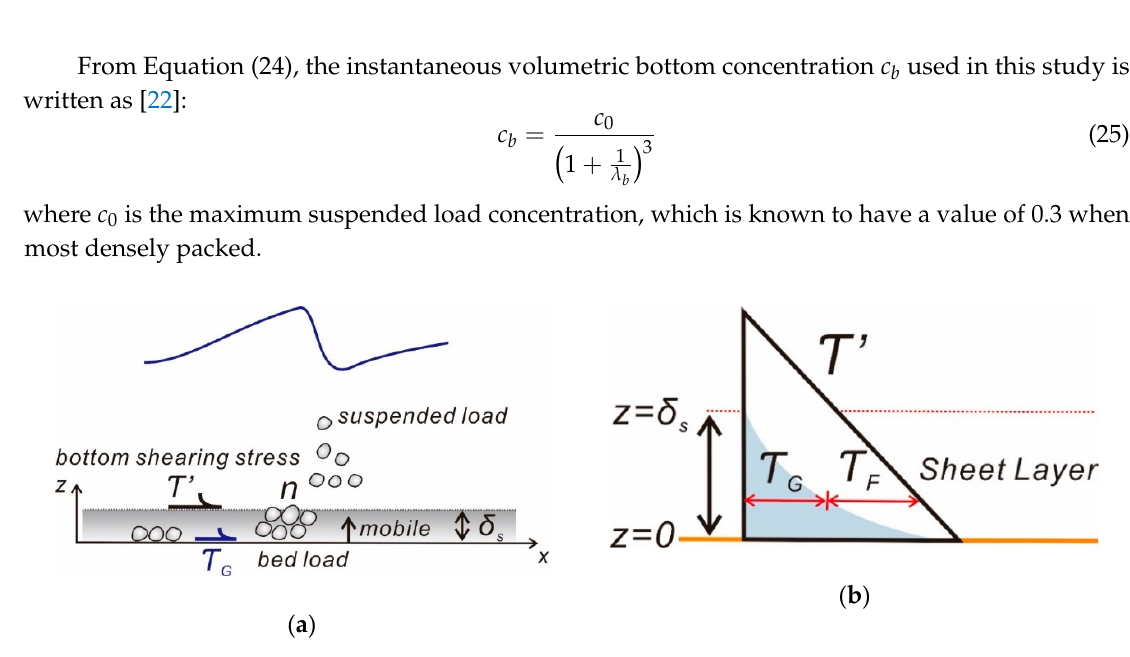
Figure 2. Partition of bottom shearing stresses into the ones carried by fluid and soil granular particle, and a distribution of shearing stress. ( a ) Partition of bottom shearing stresses into the ones carried by fluid and soil granular particle, and definition sketch of thickness of sheet layer. ( b ) distribution of shearing stress carried by fluid and soil granular particle within the sheet layer.